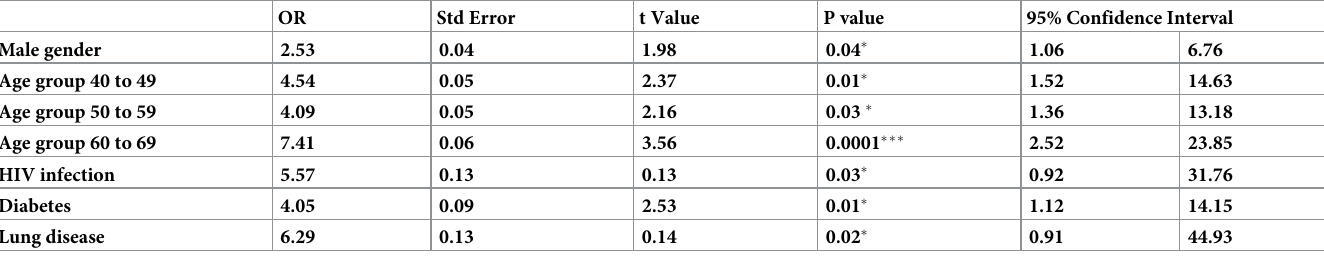
Table 3. Multivariable analysis of comorbidities associated with COVID-19